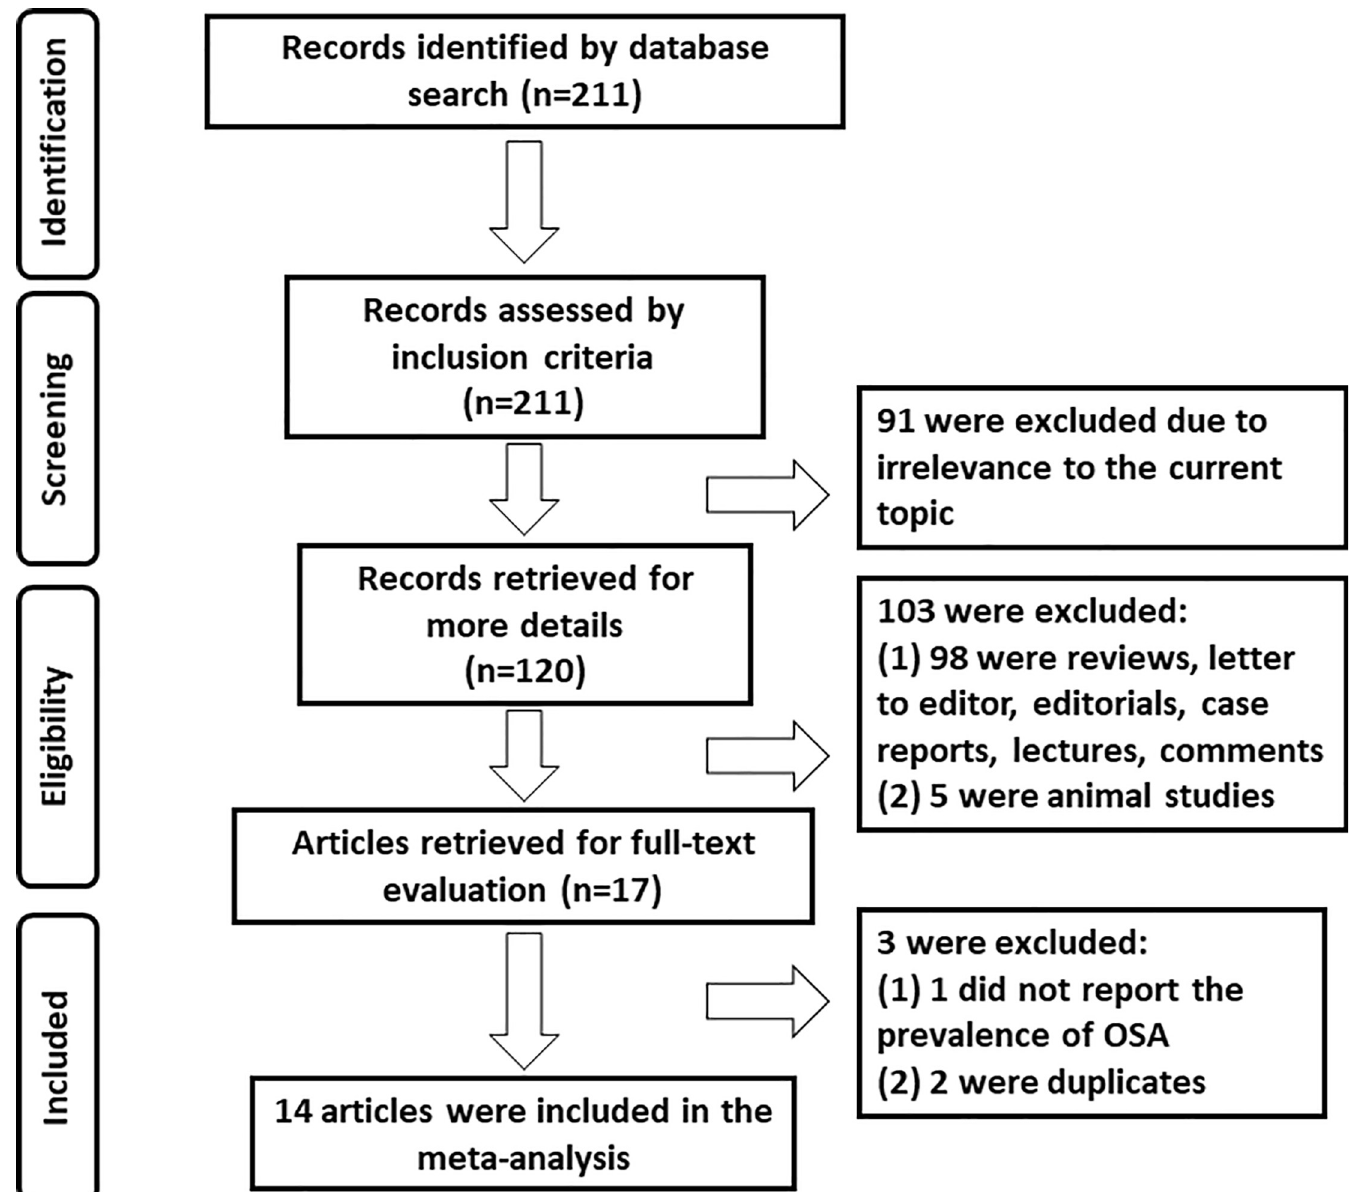
Fig 1. Flow chart of selection process for eligible articles.